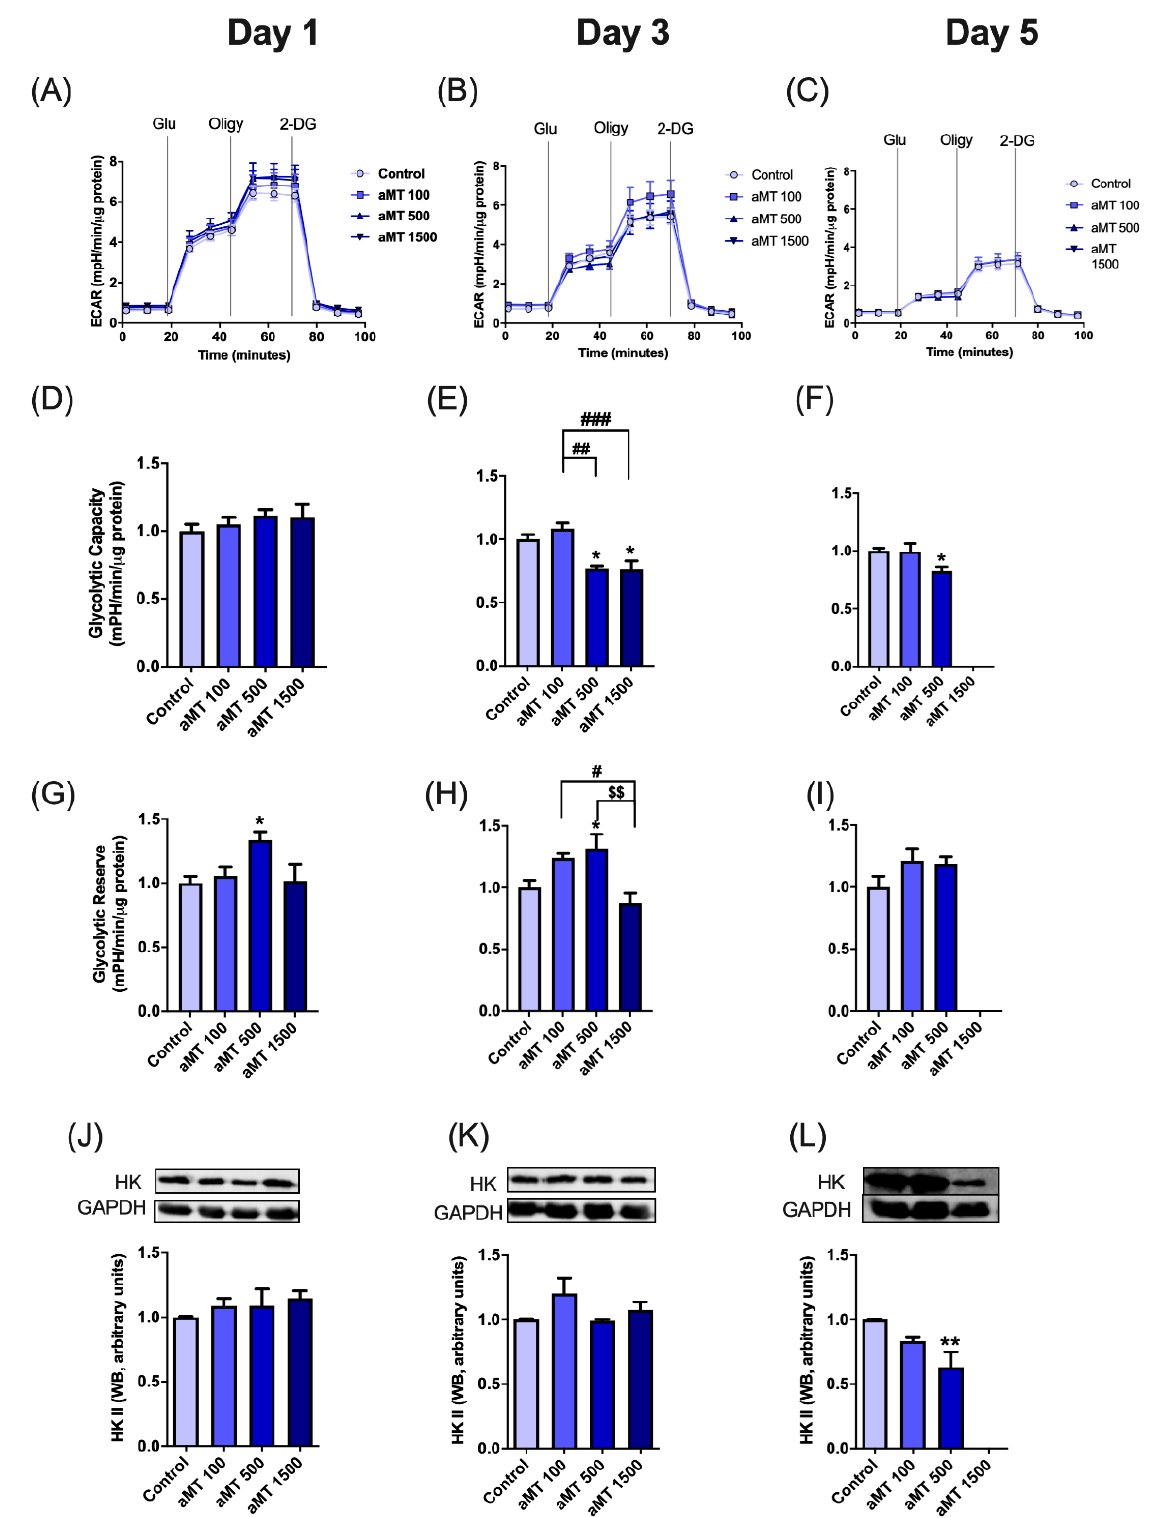
Figure 5. Effect of melatonin on glycolysis in Cal-27 cells. Extracellular acidification rate (ECAR) ( A – C ), glycolytic capacity ( D – F ), glycolytic reserve ( G – I ) analyzed by Seahorse, and hexokinase II protein expression analyzed by Western blot ( J – L ). Data for the aMT 1500 group are not shown at day 5 because most cells died; n = 6 per group. Data are presented as mean ± SEM. * p < 0.05, ** p < 0.01 vs. control; # p < 0.05, ## p < 0.01, ### p < 0.001 vs. aMT 100 µM group; $$ p < 0.01 vs. aMT 500 µM group.